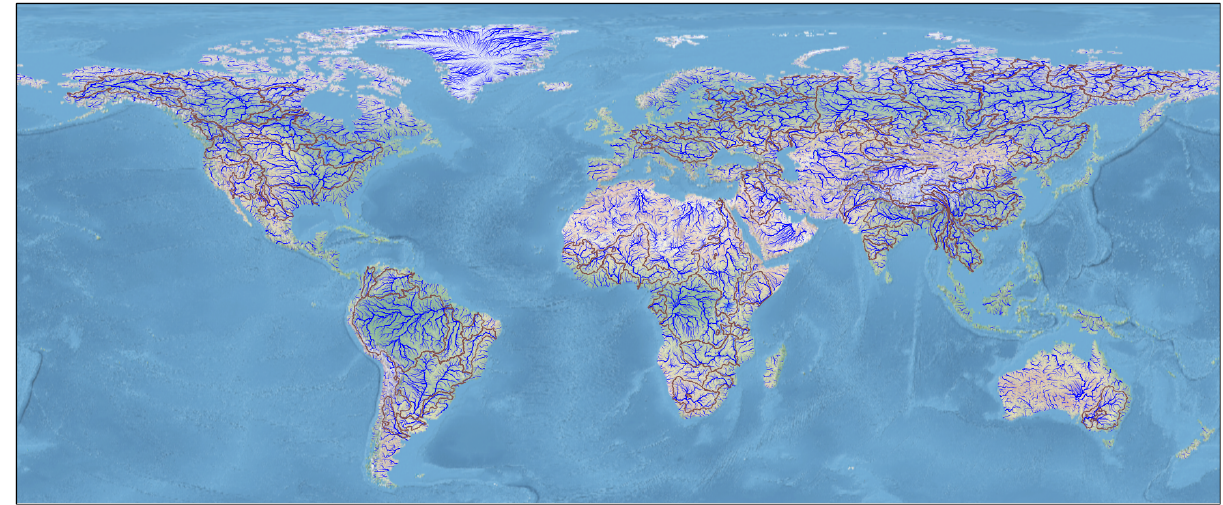
Figure 5. Global-scale river network at 1 / 12 ◦ resolution. The 69 largest basins in the world, which were used for the quality assessment, are delineated in brown.